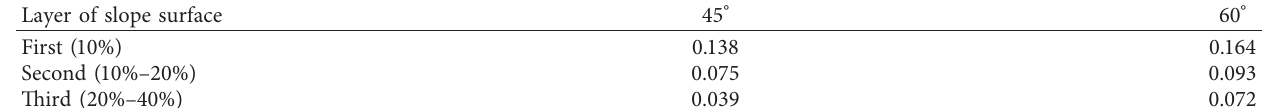
Table 6: Average along surface displacements of slopes at various frozen depths (unit: mm).